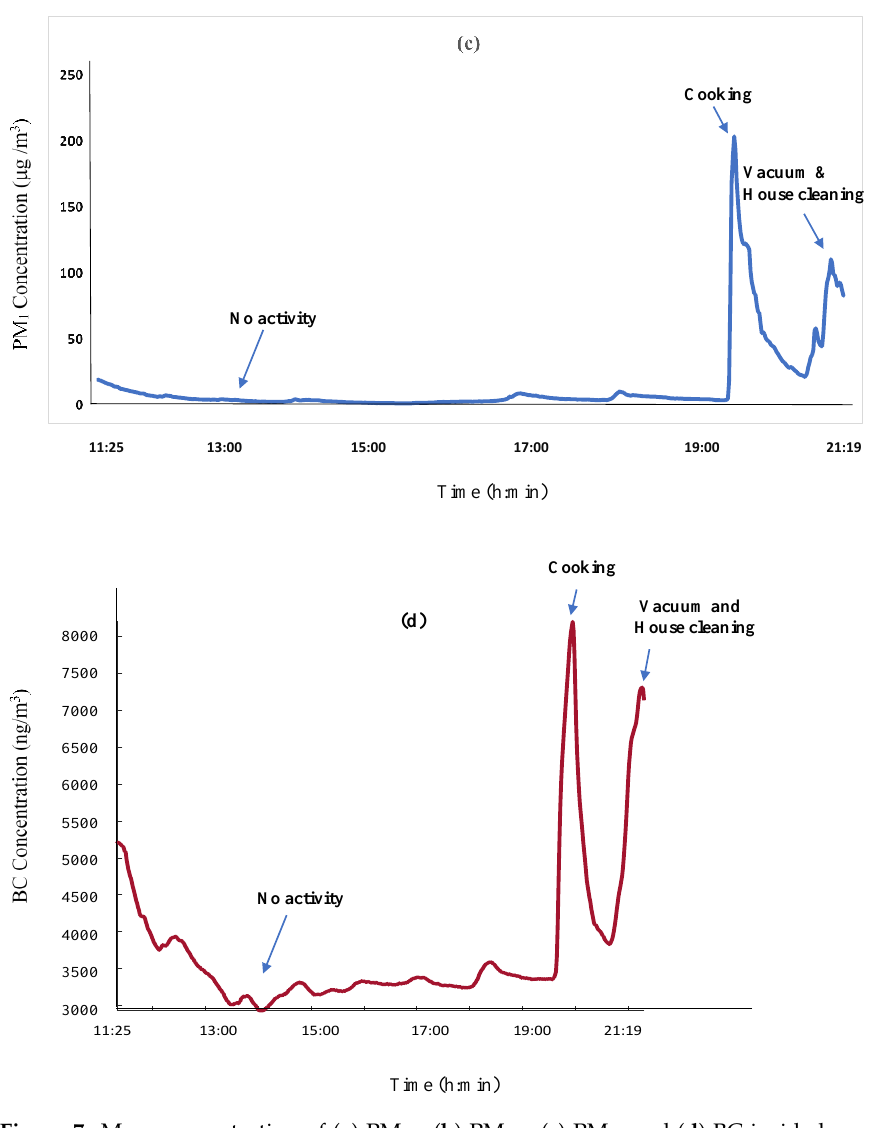
Figure 7. Mass concentration of ( a ) PM 10 , ( b ) PM 2.5 , ( c ) PM 1 , and ( d ) BC inside house in Boston (Campaign 5).